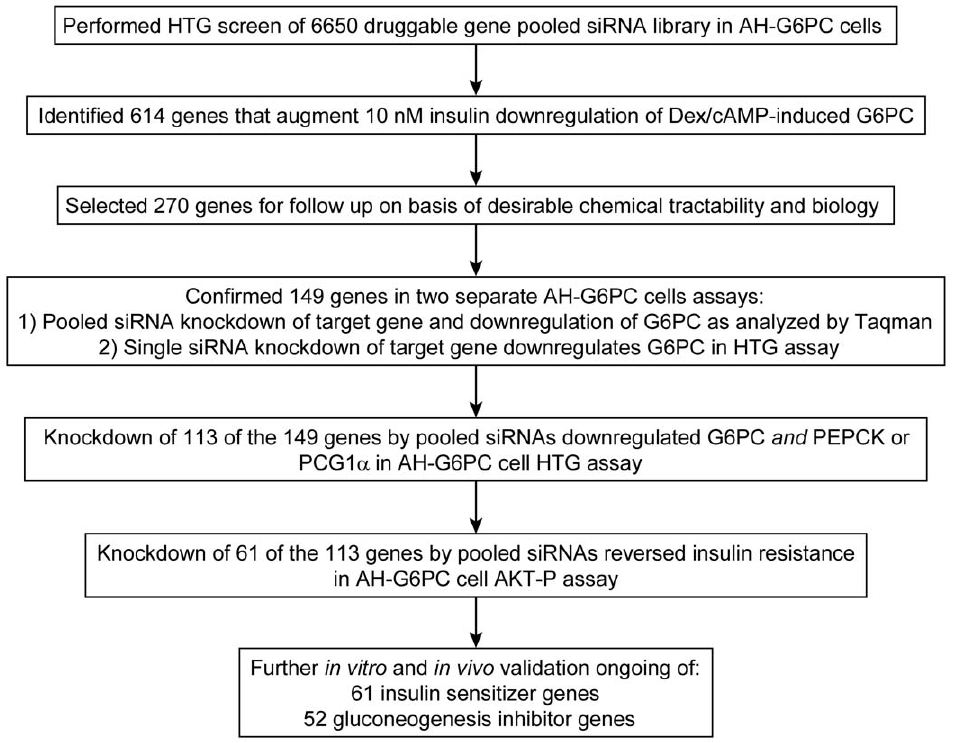
Figure 8. Schematic summary of the siRNA screening process that identified, confirmed, and characterized novel insulin sensitizer and GNG inhibitor target genes.